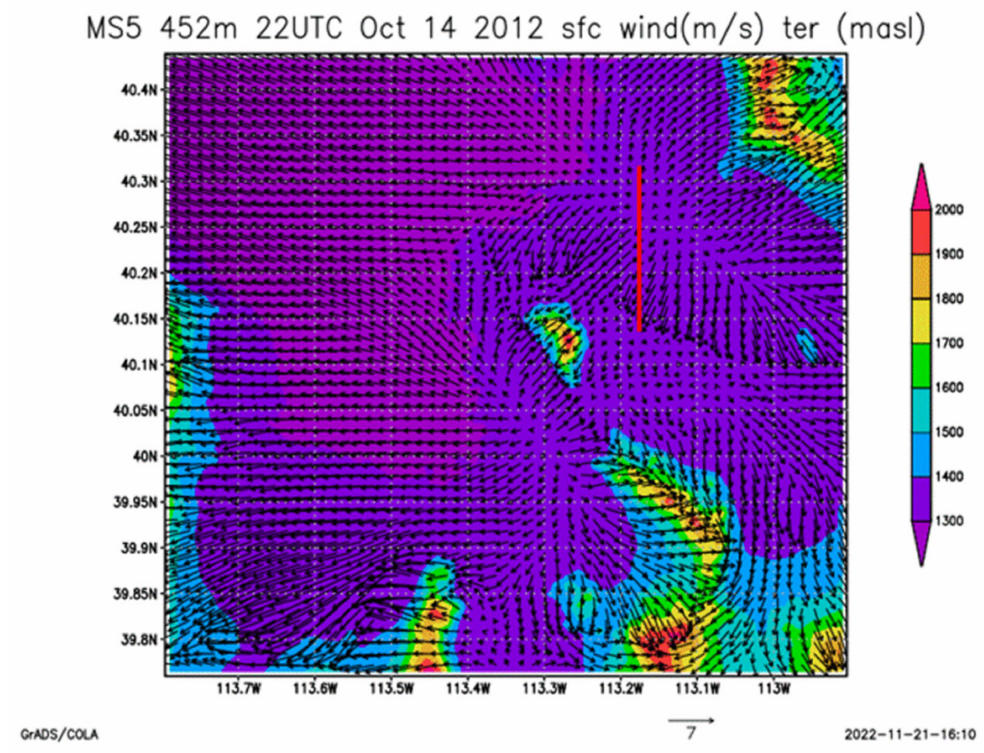
Figure 23. Model MS5 surface wind vectors (m/s) for nest 4 (0.452 km), plotted over the model terrain (m ASL), valid at 2200 UTC 10-14-2012. Red line shows meridional cross section used in subsequent